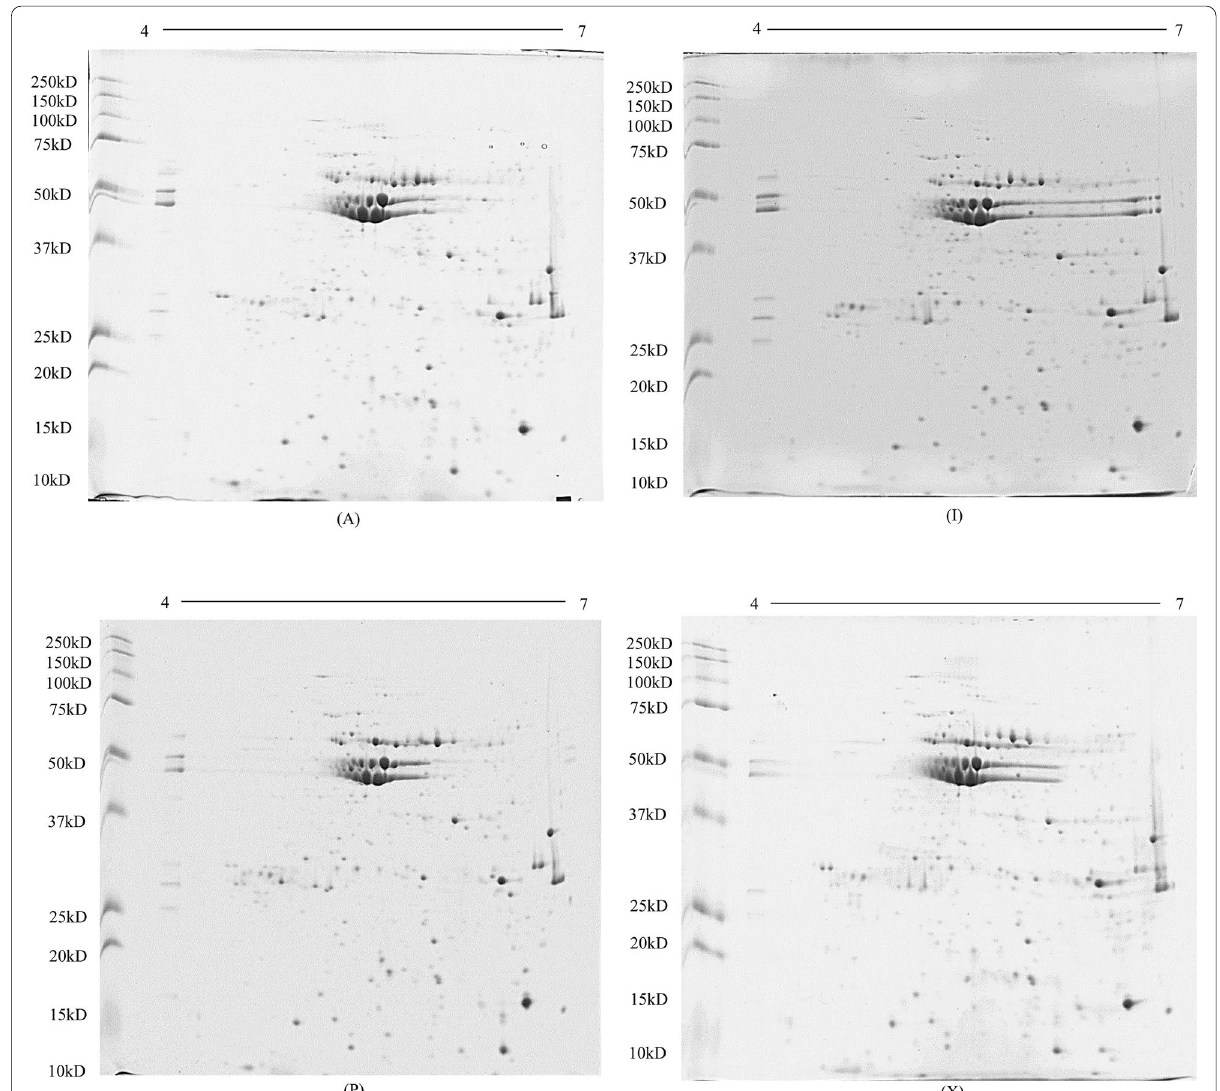
Fig. 4 Representative maps of protein profile from grains of four Brazilian cowpea ( Vigna unguiculata ) cultivars. (A) BRS Aracê, (I) BRS Itaim, (P) BRS Pajeú, and (X) BRS Xiquexique. 250 μg of proteins were separated using 13 cm linear IEF, pH 4–7 IPG strips for the first dimension and 125 g L − . 1 SDS-PAGE gels for the second dimension. Gels were stained with Coomassie Brilliant Blue